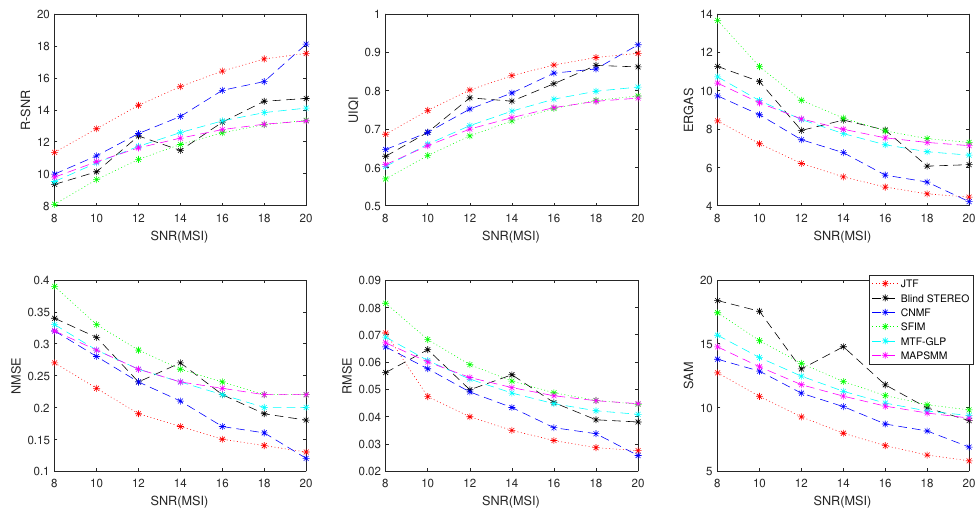
Figure 7. The results of evaluation metrics under different noises. MSI, multispectral image.